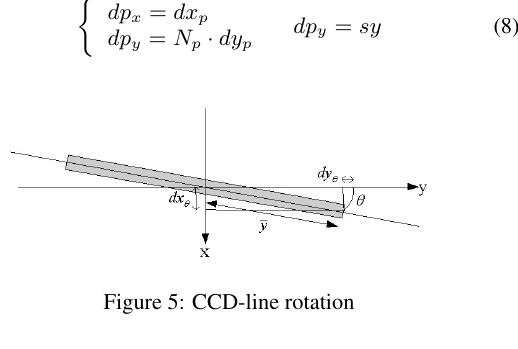
Figure 5: CCD-line rotation